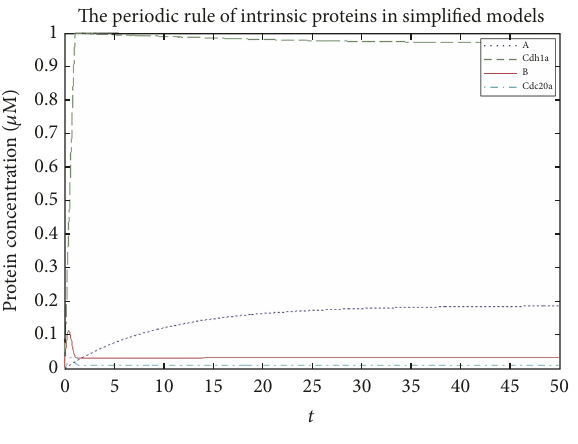
Figure 7: Termination of cell